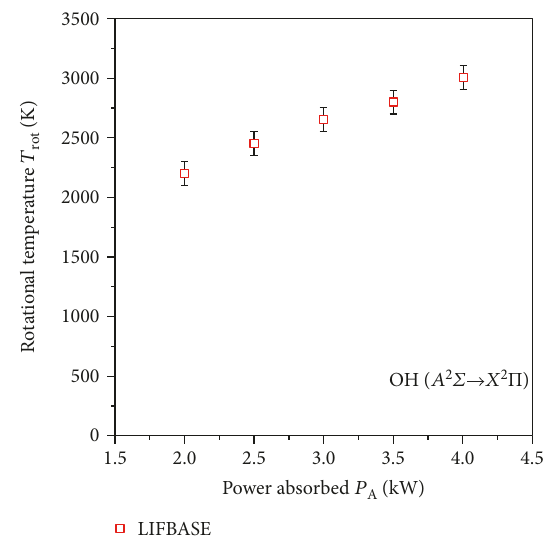
Figure 6: Measured rotational temperatures of the OH radical as a function of absorbed microwave power P